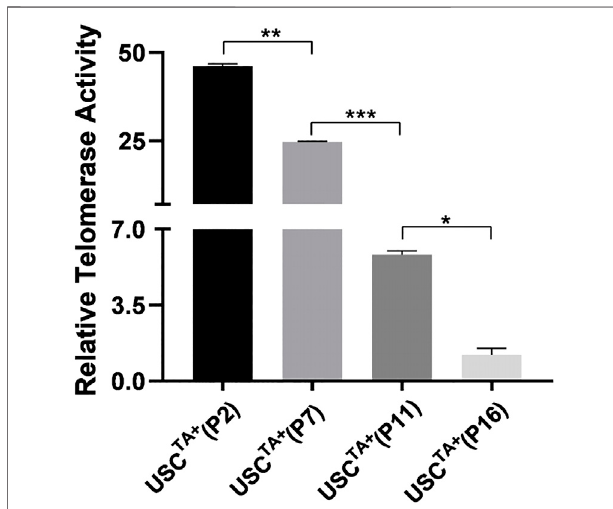
FIGURE 2 | Strength of telomerase activity declined over passage of cultured USCs. Telomerase activity of USC TA+ clones (A35 and J29) from donors of 20 and 50 years of age were determined in different passages (p2, p7, p11, and the last passage). The relative telomerase activity (RTA) of USC TA+ clones declined gradually in the passages during culture in vitro